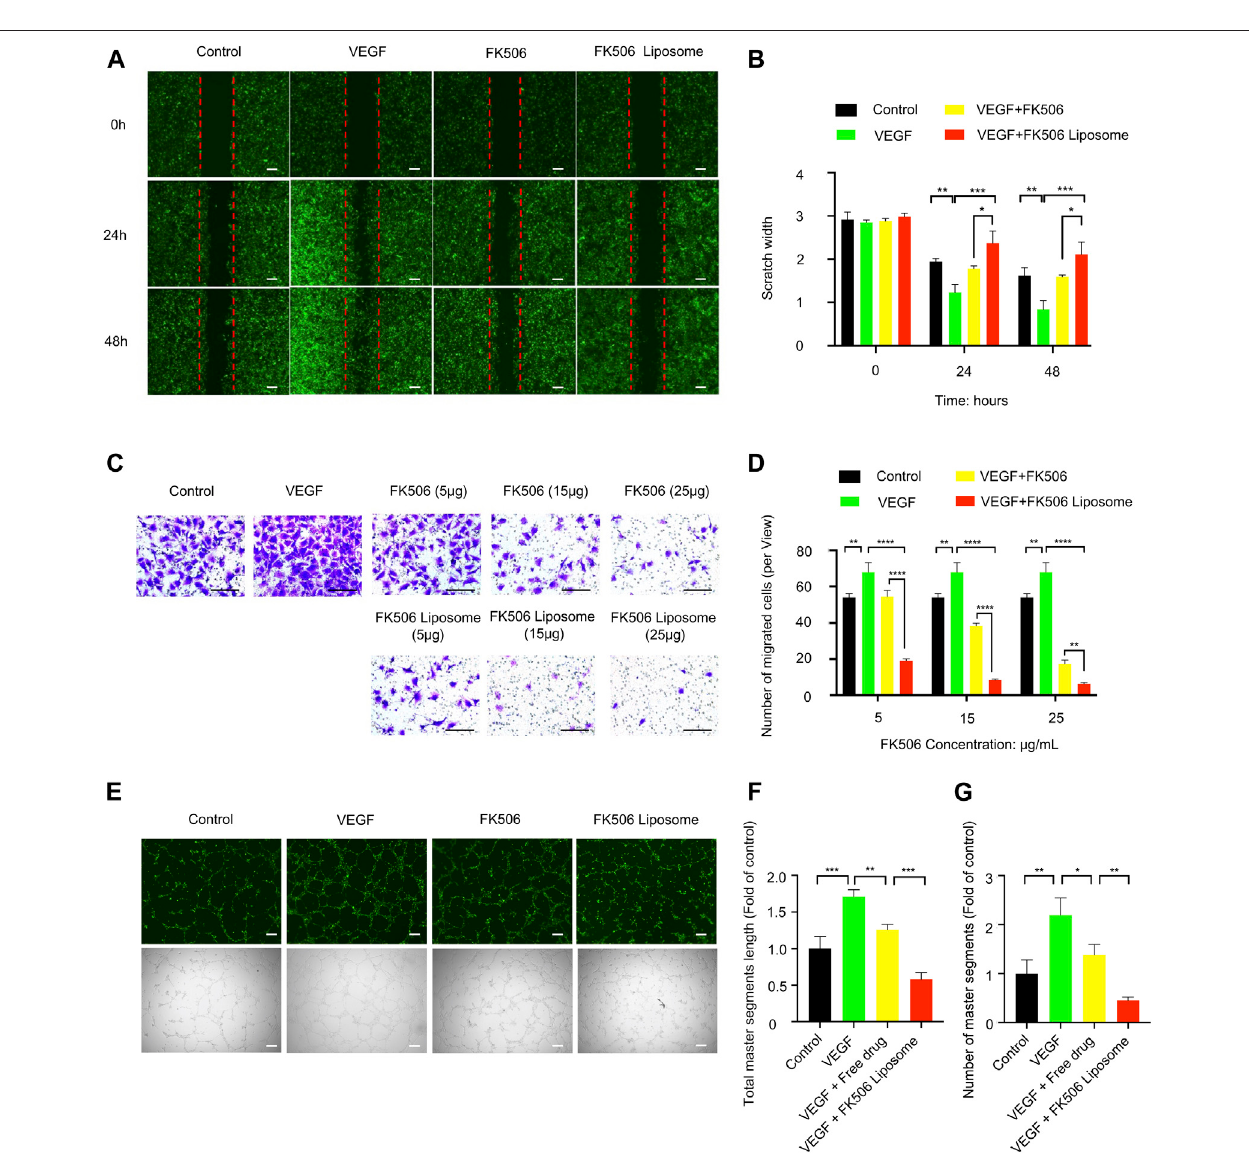
FIGURE2 | In vitro evaluationofFK506liposomesin theinhibitionofangiogenesis. (A) FK506 liposomes inhibited the migrationof HUVEC-GFP cells bywounding healing assay (scale bar: 200 μ m, n (cid:2) 3). (B) Quantitative analysis of the scratch widths. (C) Different concentrations of FK506 liposomes inhibited the migration of HUVEC-GFP cells by transwell migration assay (scale bar: 100 μ m, n (cid:2) 3). (D) Quantitative analysis of the number of migrated cells in each view. (E) Tube formation activity of HUVEC-GFP cells. Representative fl uorescence and bright- fi eld images of HUVEC-GFP cells after co-incubation with 15 μ g/ml FK506 or FK506 liposomes for 6 h (scale bar: 200 μ m, n (cid:2) 3). Quantitative analysis of (F) total master segment length and (G) number of master segments.